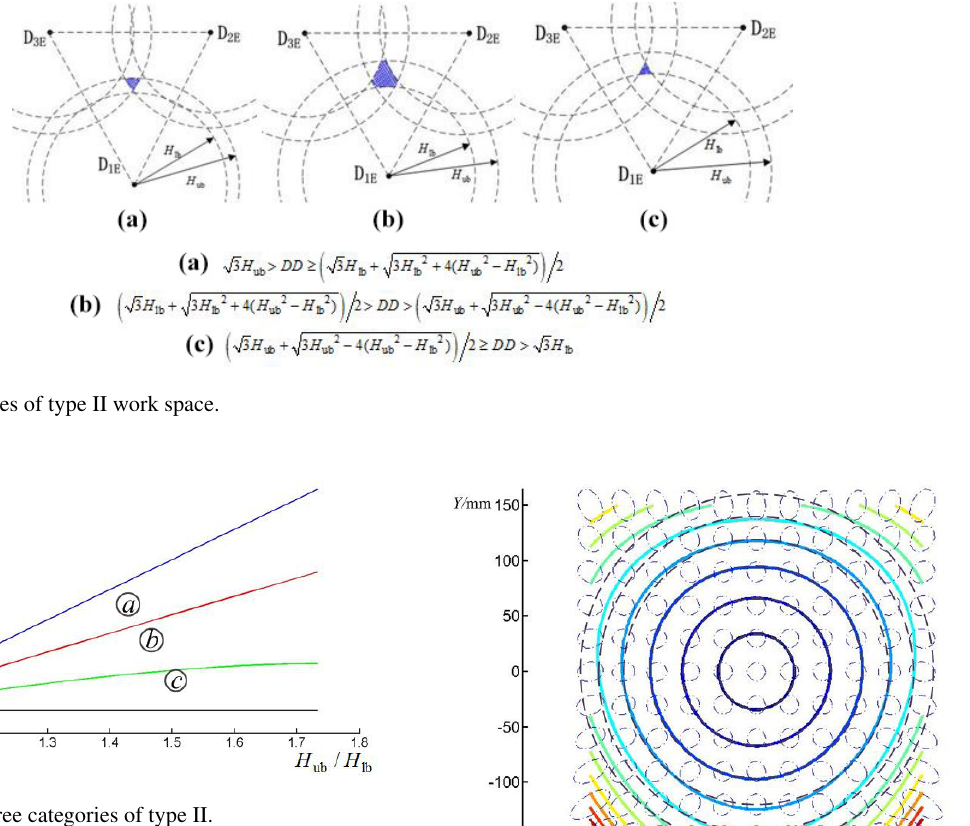
Figure 10. Ranges of three categories of type II.